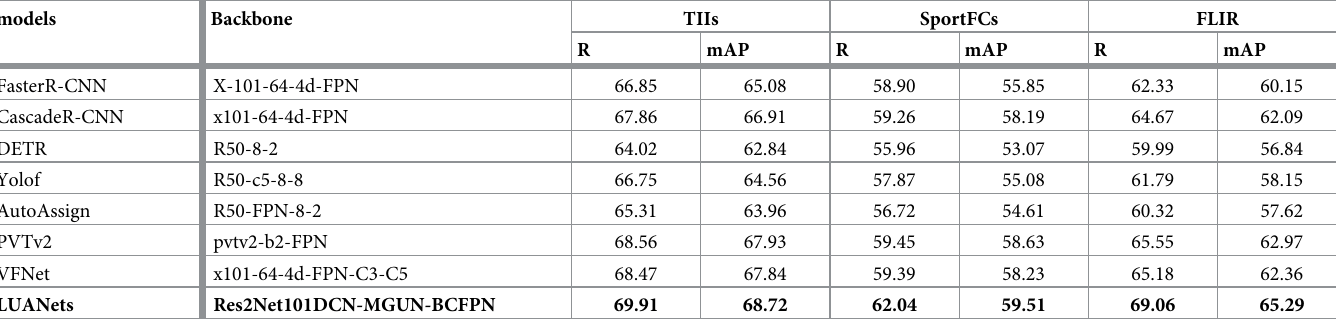
LUANets represents our proposed detection framework. MGUN represents our proposed local embedded U-shaped module. BCFPN represents our proposed bidirectional cross-aggregation